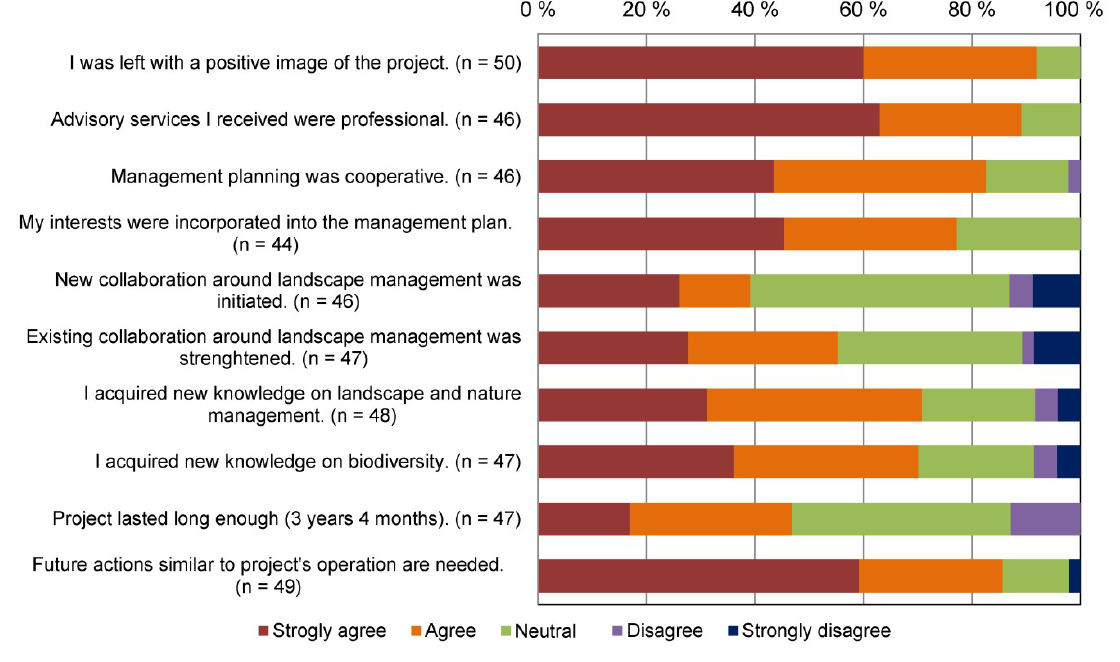
Figure 6: Respondents’ agreement with statements reflecting contentment to the project. For each statement, respondents chose the alternative that best corresponded to their own